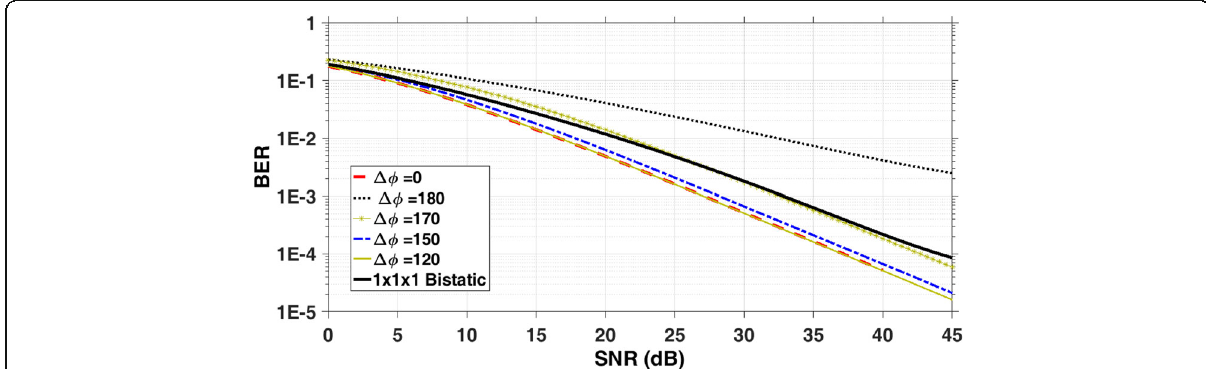
Fig. 6 BER versus SNR for phase deviation ( Δ φ , in degrees) from the optimal value ( Δ φ = 0) for a system with two query transmitters (2 × 1 × 1). The system performance is less sensitive to phase miss alignments up to